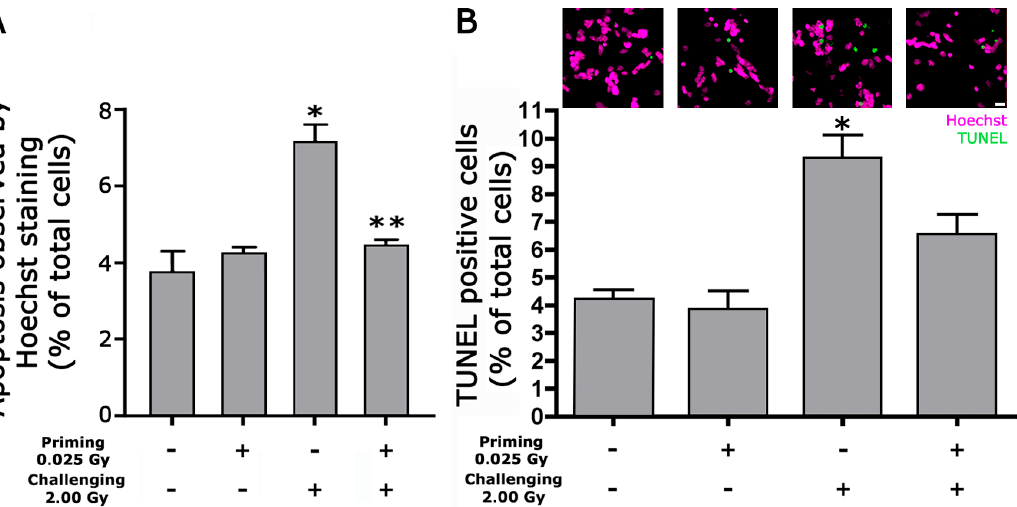
Figure 1. The priming dose reduces the number of apoptotic cells induced by irradiation with 2 Gy. The graphs show the percentage of apoptotic cells 24 h after irradiation with 2 Gy with or without pretreatment with 0.025 Gy. In ( A ), apoptosis was observed by Hoechst 33258 staining evaluating nuclear morphological changes related to apoptosis (condensation of chromatin and nuclear fragmentations) (A; p < 0.0001 one-way ANOVA * p < 0.00001 vs. CTR ** p < 0.0001 vs. 2 Gy, unpaired two-tailed Student’s t -test). In ( B ), apoptosis was evaluated by the TUNEL assay using Hoechst vital dye for total cell number evaluation. Data are expressed as a percentage of total cells. Graphs represent the mean ± SEM of at least five independent experiments. Example pictures of TUNEL-positive nuclei (green) are shown above the graph * p < 0.05 versus the control (Wilcoxon signed-rank test). Scale bar = 20 μ m.